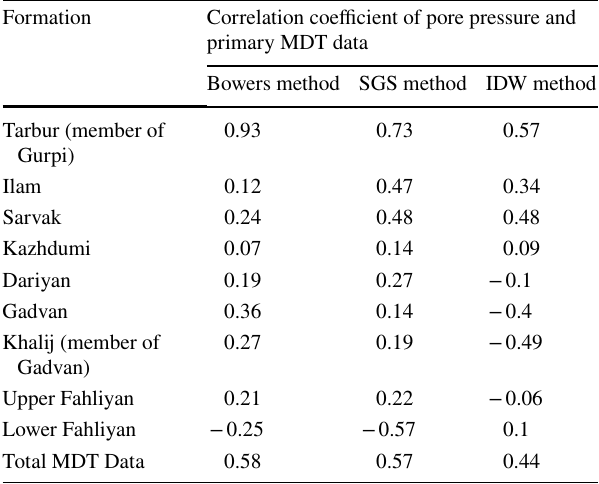
Table 5 Correlation coefficients of formation pore pressure cubes of studied field using neural network based on Bowers, SGS, and IDW models with primary MDT data Formation Correlation coefficient of pore pressure and primary MDT data